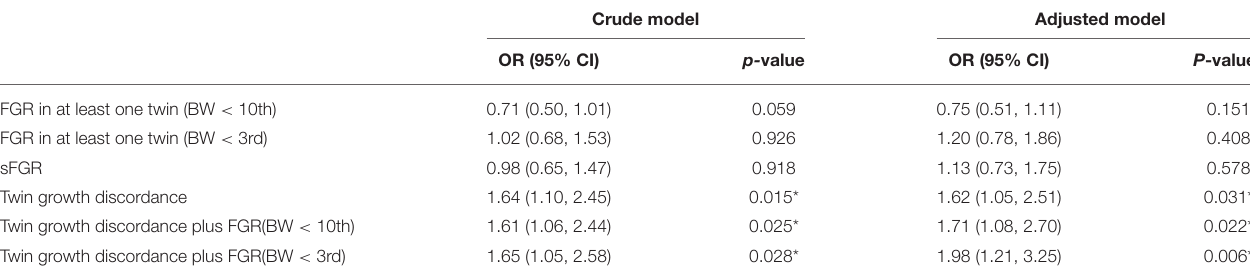
TABLE 2 | Logistic regression analysis for the associations between twin growth discordance, fetal growth restriction (FGR), and risk of PPH.